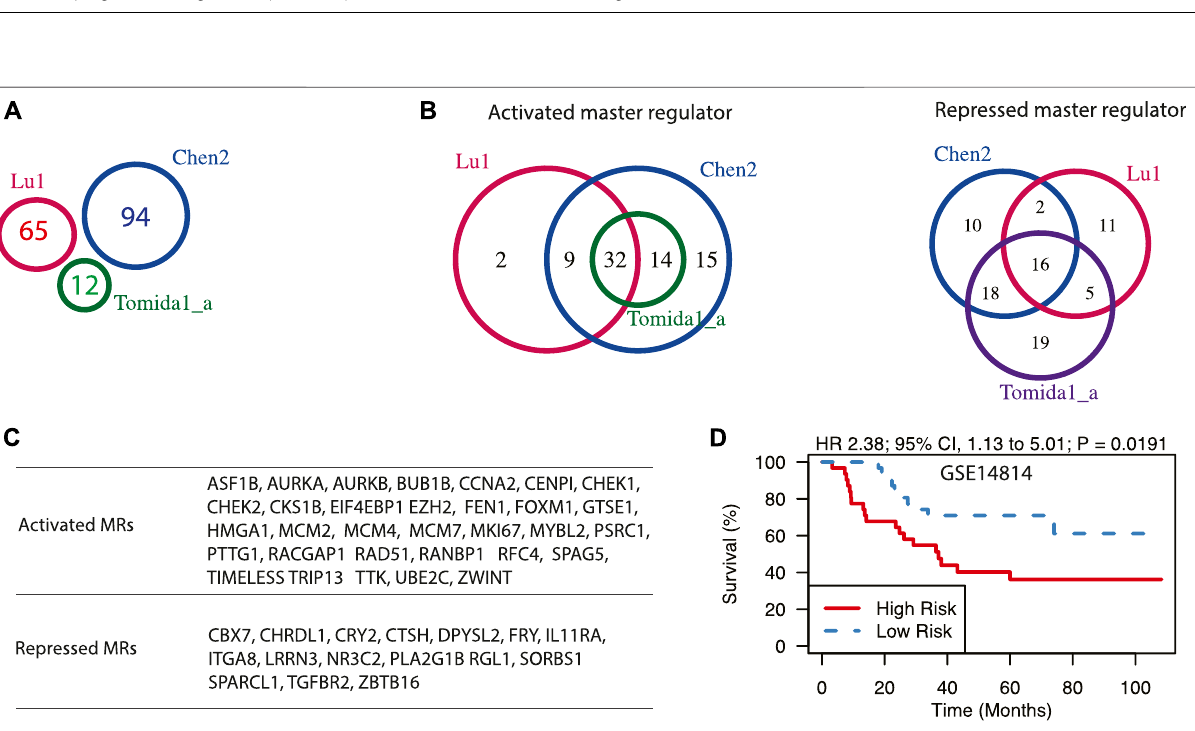
Frontiers in Bioinformatics |